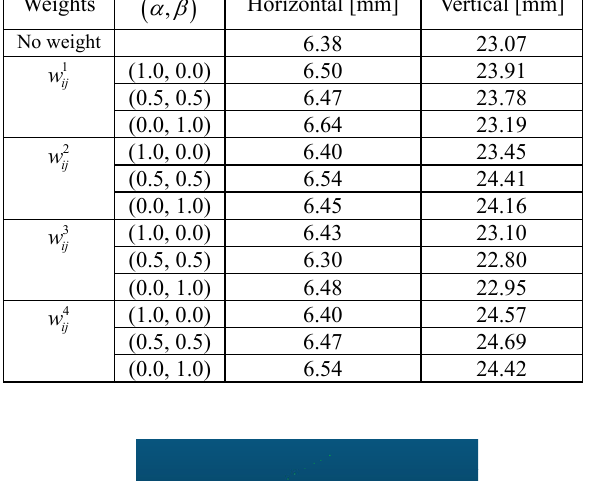
Table 4. Accuracy evaluation of experiment 1